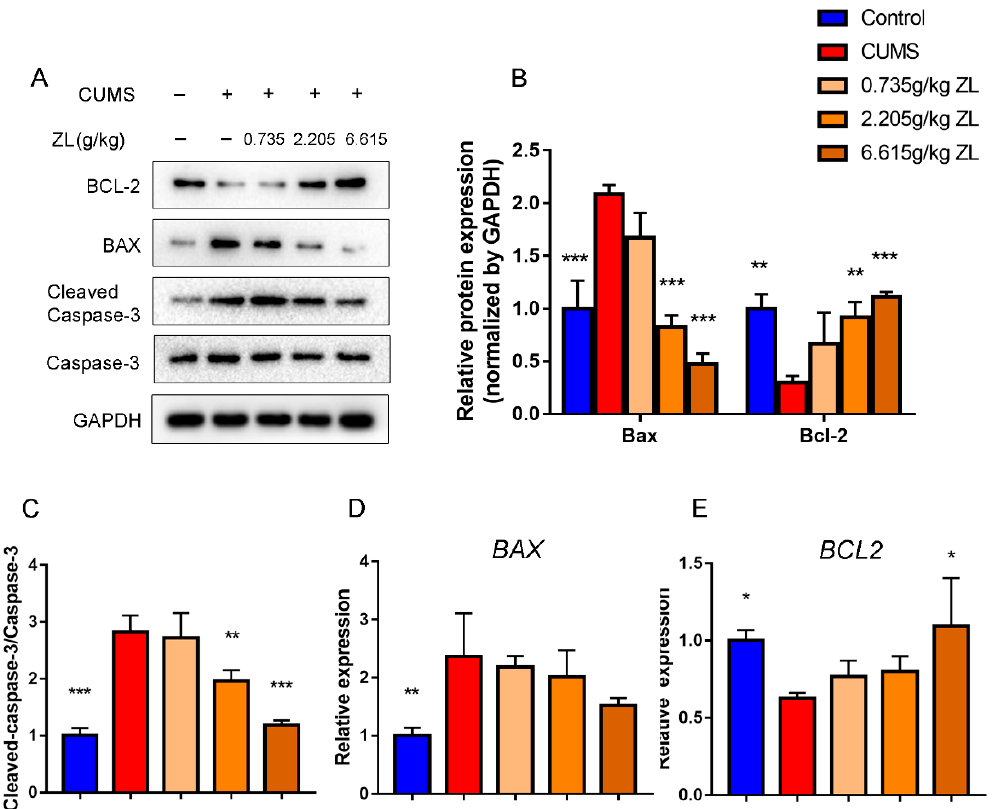
Figure 7. ZL exerted neuroprotective effects by inhibiting apoptosis. ( A – C ) Protein expressions of Bcl-2, Bax, cleaved caspase-3 and caspase-3 in the hippocampus at the end of experiment determined by western blotting. Quantified protein level was normalized to that of GAPDH using densitometry ( n = 3). ( D , E ) Relative gene expressions of Bcl-2 and Bax in the rat hippocampus quantified by qPCR ( n = 3). GAPDH was employed as the loading control. All data are represented as mean ± SD. * p < 0.05, ** p < 0.01, and *** p < 0.001 versus CUMS group.